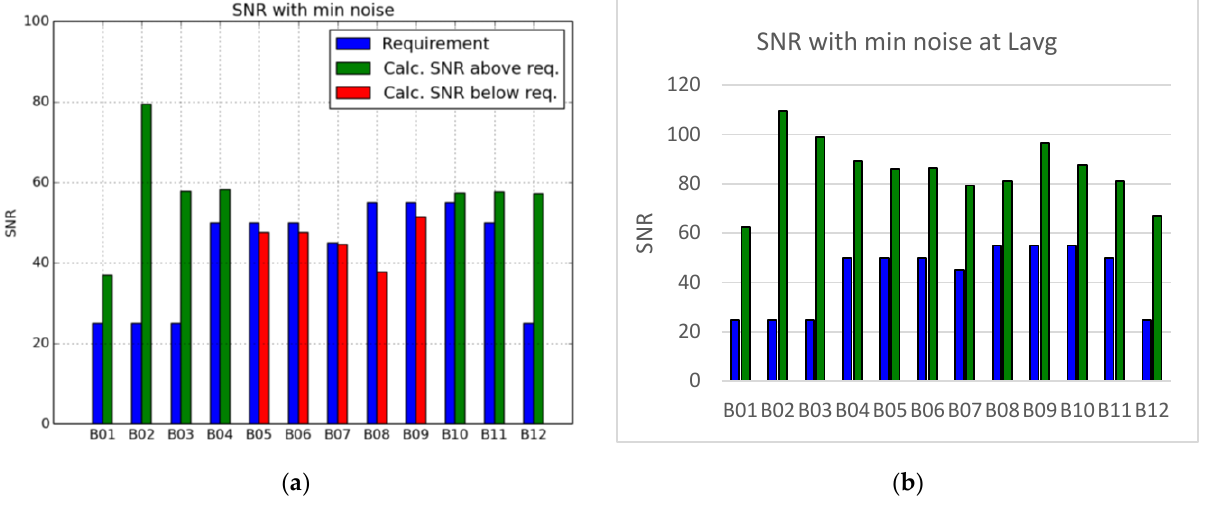
Figure 12. ( a ) SNR estimation for all spectral bands at Lmin; ( b ) SNR estimation for all spectral bands at Lavg.